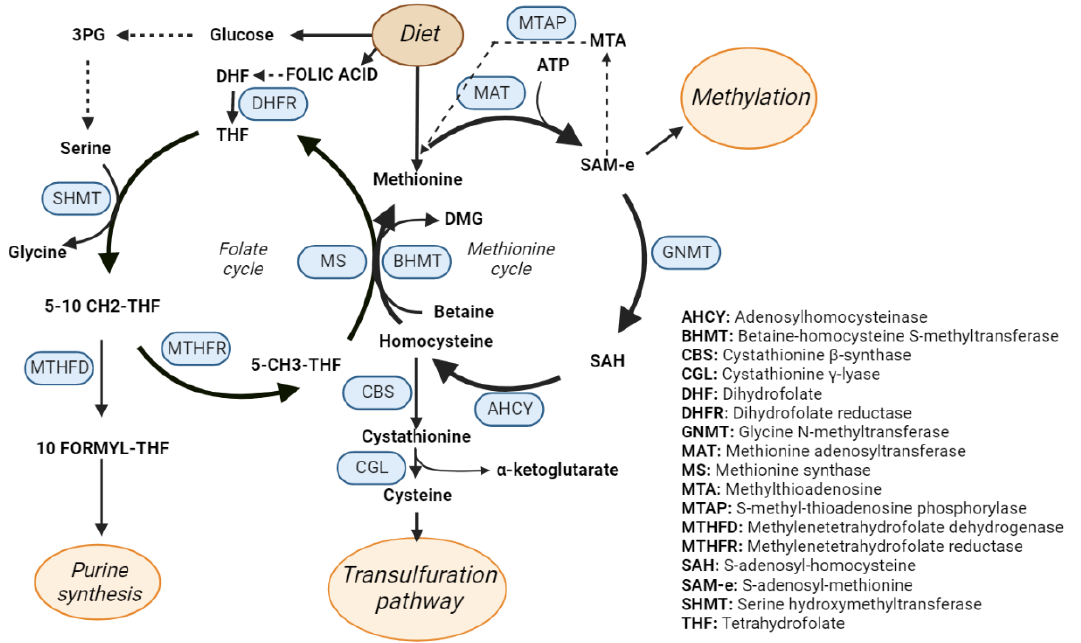
Figure 3. One-carbon metabolism (OCM). Schematic representation of the OCM cycle that includes the methionine and folate cycles. The enzymes catalyzing the OCM reactions are highlighted in blue. Methionine cycle is also involved in the biosynthesis of phospholipids [75]. Phospha- tidyl choline, one of the main components of the cellular membrane [76], is synthetized through three sequential methylations of phosphatidylethanolamine where SAM donates the methyl groups [77]. SAM is the main donor of methyl groups in methylation reactions of the cell like histone or nucleic acids methylation, thus regulating epigenetics [78,79]. Upon decarboxylation, the propylamine group of SAM can be used for polyamine syn- thesis leading to the synthesis of spermidine and spermine in two consecutive reactions where methylthioadenosine (MTA) is also produced. This metabolite enters the methio- nine salvage pathway in a reaction catalyzed by methylthioadenosine phosphorylase (MTAP) and it is recycled back into methionine. OCM has been extensively studied in the liver, where it has a tissue specific architec- ture. The metabolic balance of OCM must be precisely regulated in the liver, as it has been shown that tiny alterations lead to loss of function and dedifferentiation of hepatocytes. In mammals, there are two genes encoding MAT enzymes, MAT1A and MAT2A [80]. MAT1A is mostly expressed in differentiated hepatocytes whereas MAT2A is expressed in the fetal liver, in extrahepatic tissues, and in liver cancer. In contrast to MAT2A, MAT1A has a high methionine metabolic capacity resulting from its activation by this amino acid and the lack of inhibition by the product SAM [81]. Moreover, MAT1A has a specific regulatory mechanism based on the redox regulation of its activity (that prevents excessive ATP consumption and cellular de-energization in critical liver injury processes [82]. Preservation of high MAT1A and low MAT2A expression levels is essential to main- tain a functional and differentiated liver [83]. Experimental evidence demonstrates that liver MAT1A expression is associated with hypomethylation and elevated levels of chro- matin acetylation, while its silencing leads to hepatocyte proliferation and liver tumor progression [84]. In turn, SAM has a key role in preserving MAT1A expression and pre- venting the switch to MAT2A, but its accumulation also leads to HCC development [85]. For this reason, it appears that a precise regulation of the SAM intracellular content is essential for the preservation of hepatocyte homeostasis. In line with this idea, it has been demonstrated that SAM has a protective role against liver insults compromising its